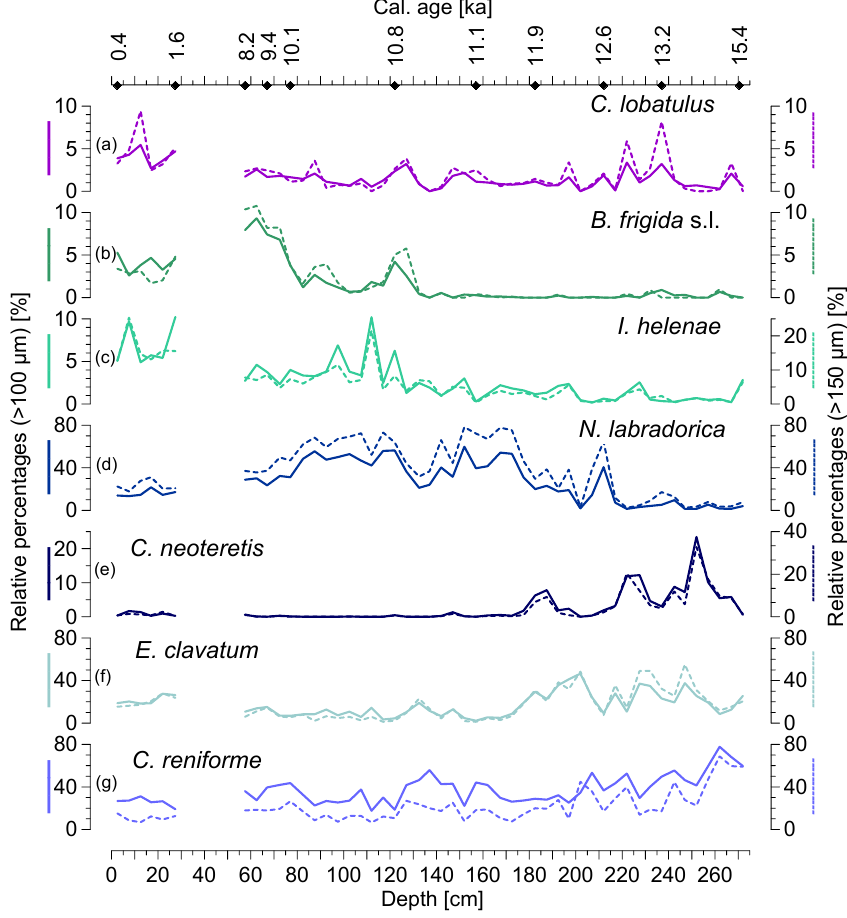
Figure A1. Relative percentages of the dominant calcareous benthic foraminifera. Comparison of fraction >100µm (solid lines) vs. frac- tion>150µm (dashed lines). (a) Cibicides lobatulus . (b) Buccella frigida s.l. (c) Islandiella helenae . (d) Nonionellina labradorica . (e) Cas- sidulina neoteretis . (f) Elphidium clavatum . (g) Cassidulina reniforme . Note similar pattern of the faunal distributions. The highest offset can be recognized for N. labradorica and C. reniforme because the majority of N. labradorica appears in the >150µm fraction whereas the majority of C. reniforme appears in the >100µm fraction. Black diamonds: calibrated radiocarbon